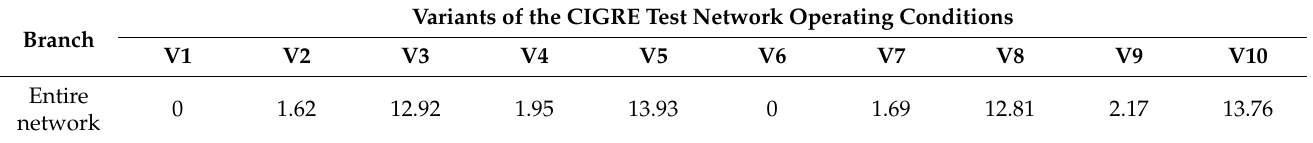
Table 10. The risk of energy losses increasing R ∆ E (%) in the CIGRE test